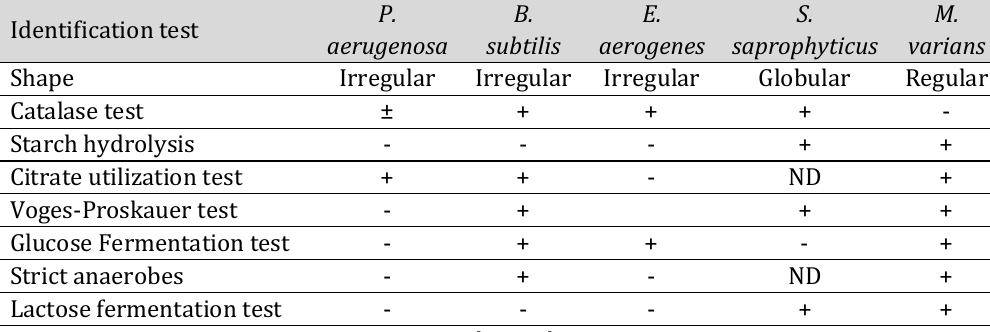
Table 4. Characteristics of bacteria isolated from the treated raw palm